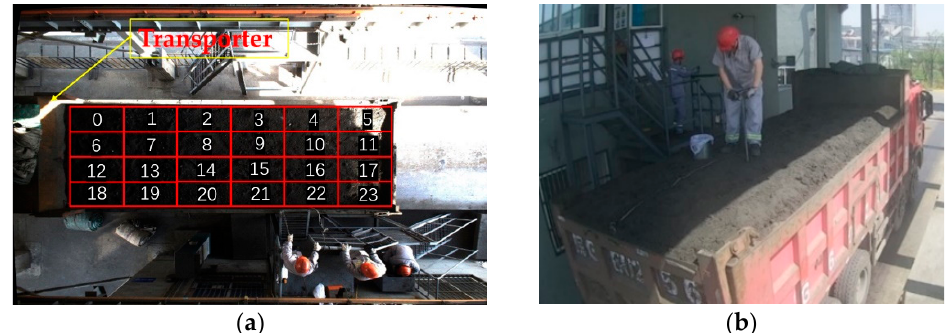
Figure 1. Manual random sampling. ( a ) Sampling area division. ( b ) Manual sampling.